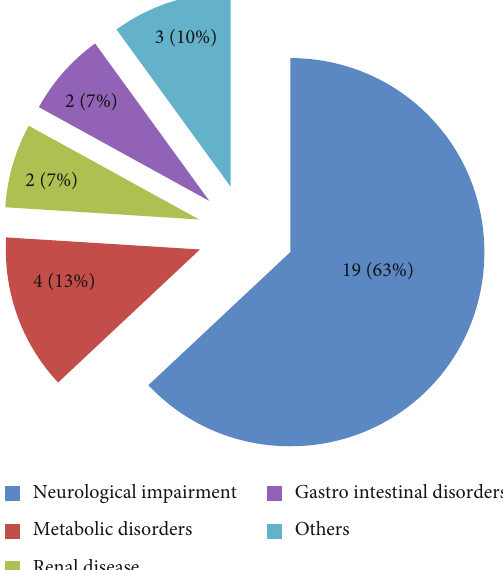
Figure 2: Patient ’ s underlying disease at the time of referral.